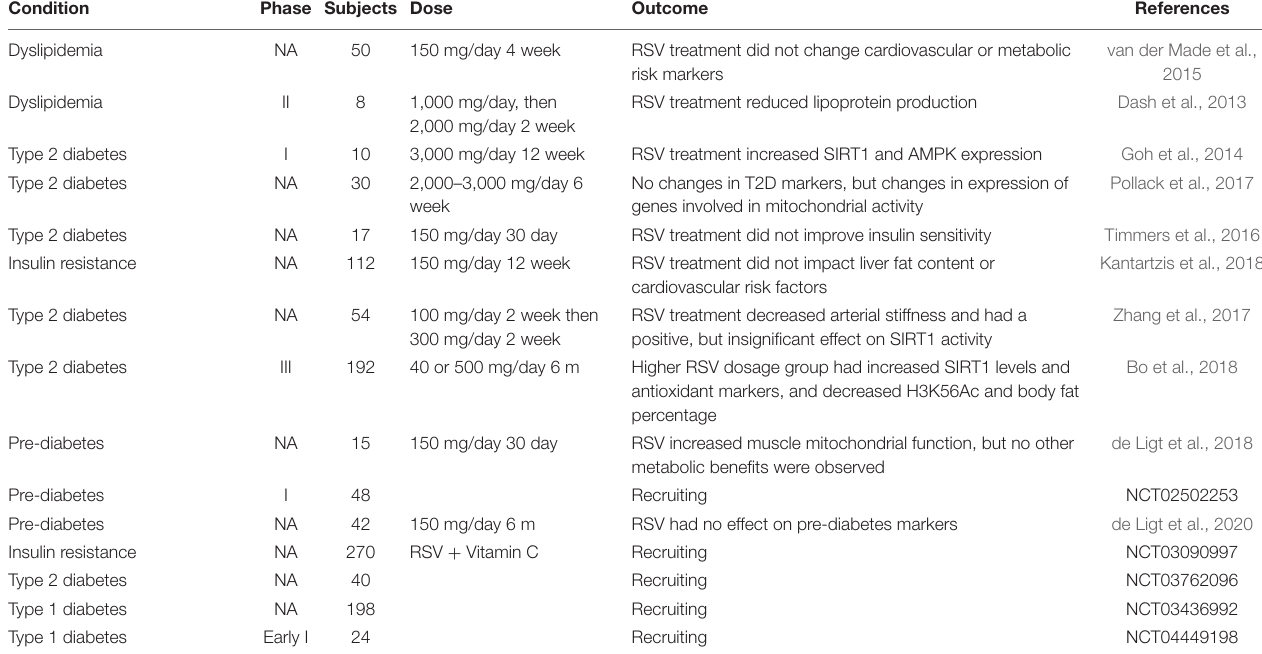
TABLE 5 | Clinical trials of resveratrol for